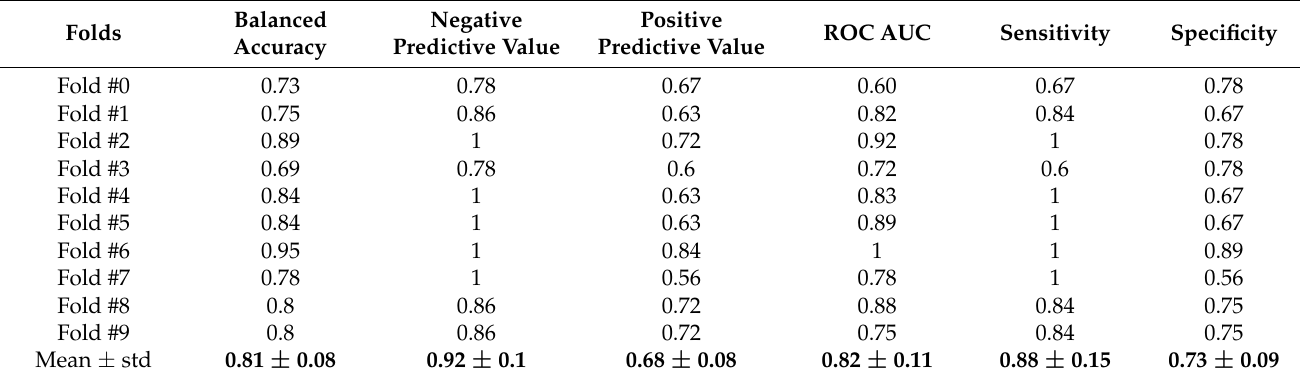
Table 3. Evaluation of the CAD risk-prediction problem over 10-fold using imaging and non-imaging data (AUC, area under curve).